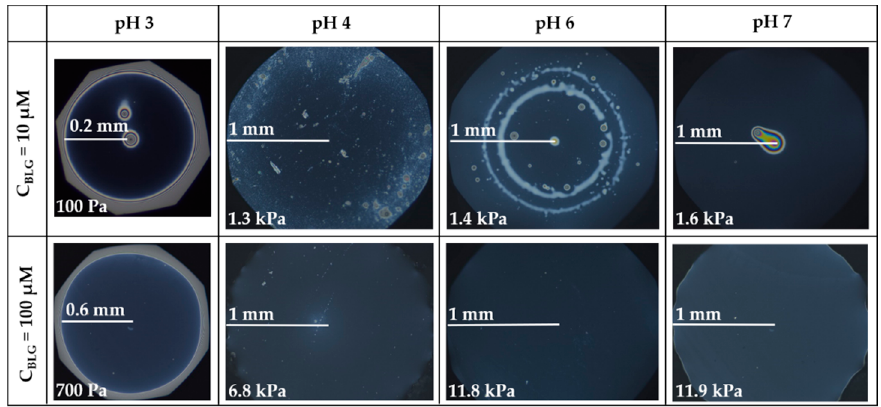
Figure 4. Black foam films obtained at different pH and C BLG (C buff = 10 mM) formed slowly by protocol ‘A’; the photos were taken at moments close to film rupture.